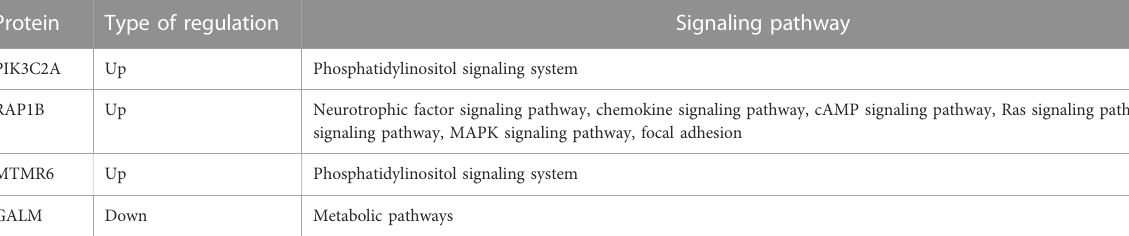
TABLE 3 Signaling pathways involved in partially interaction protein molecules.